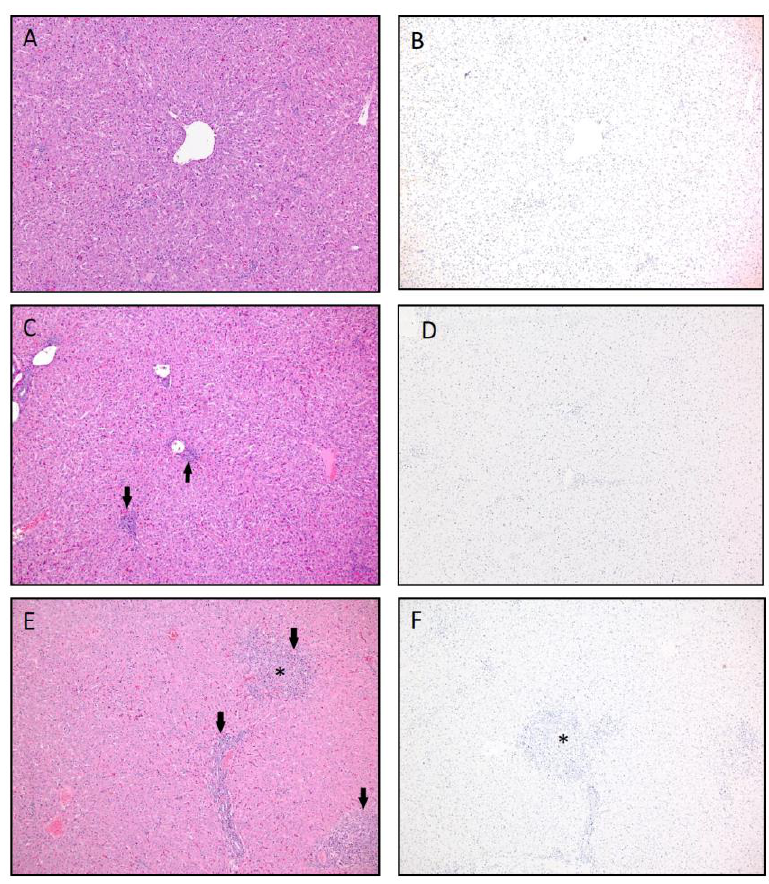
Figure 7. Liver histopathology and viral antigen immunohistochemistry (IHC) representative of absent to minimal to moderate hepatic inflammation in vaccinated animals. ( A ) Hematoxylin and eosin stain (H&E) of normal liver. H score was 0 = no lesions (Group 3, Animal #3, 10 dpc). ( B ) No viral antigen was present by IHC (Group 3, Animal #3, 10 dpc). ( C ) H&E of the liver with low numbers of periportal lymphocytes and plasma cells (arrows). H score was 1 = minimal inflammation (Group 2, Animal #9, 10 dpc). ( D ) The tissue was also negative for viral antigen by IHC (Group 2, Animal #9, 10 dpc). ( E ) H&E of multifocal inflammation in portal tracts (arrow) as well as a focus of inflammation with hepatocyte loss (*). H score was 2.5 = moderate inflammation (Group 4, Animal #14, 7 dpc). ( F ) IHC was negative for viral antigen (Group 4, Animal #14, 7 dpc). 100× magnification. The H score is the hepatic histopathology lesion score based on the lesion character, amount of hepatic parenchyma affected and lesion severity on a scale from 0 (no lesions) to 4 (severe lesions_ (see Table 1).